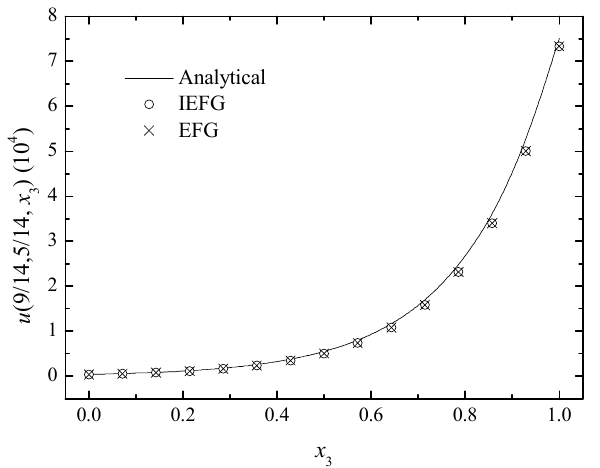
Figure 15. The comparison of the numerical and analytical solutions of the two methods along the x 3 -axis.